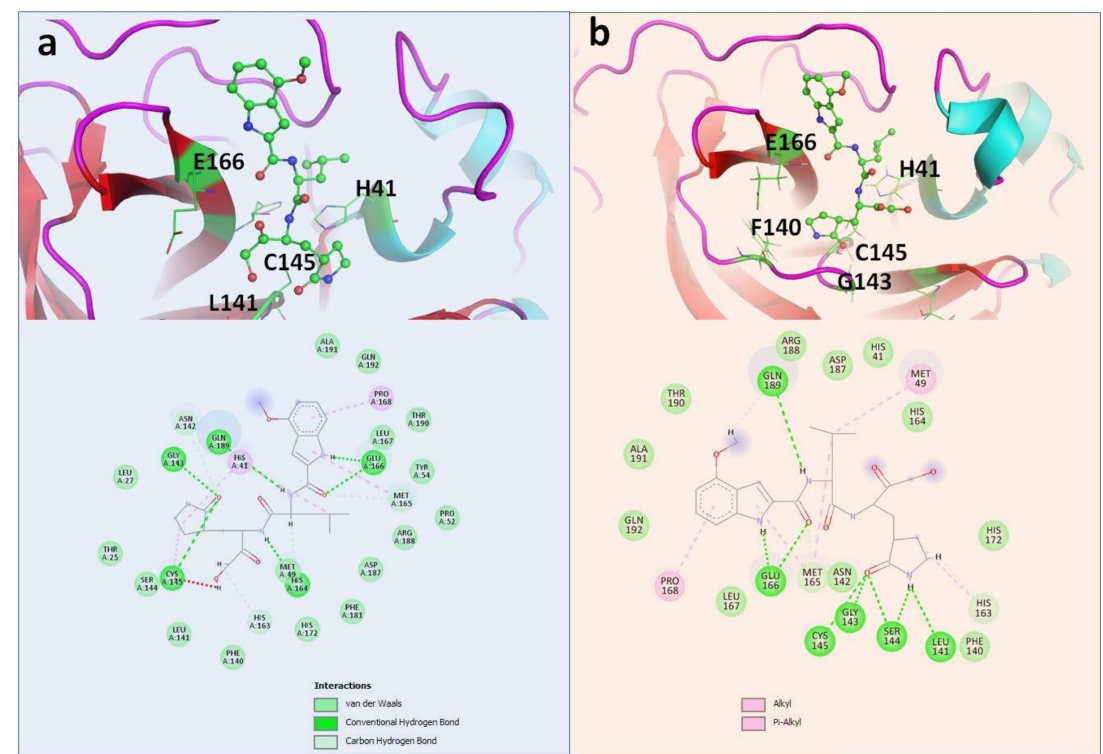
Figure 3. Complex of PF-00835231 within the active site of ( a ) WT; ( b ) Y54C.